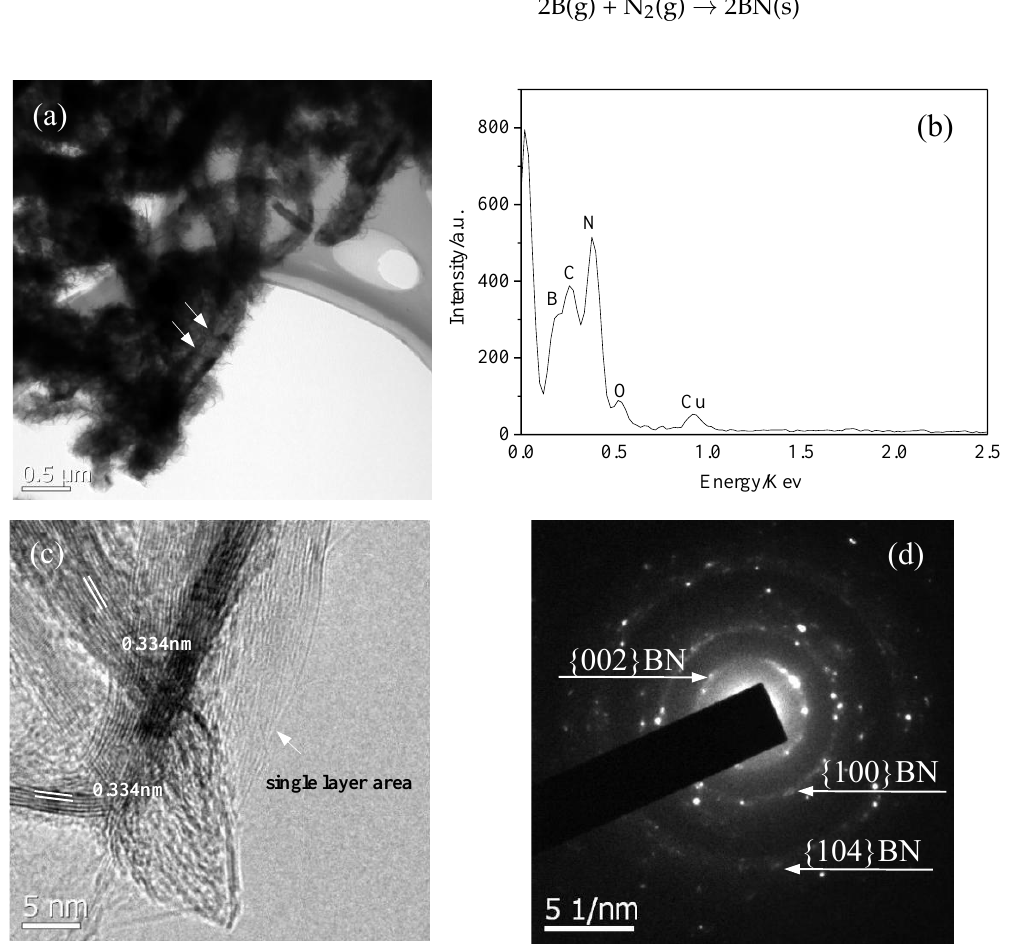
Figure 5. ( a ) TEM image of the product; ( b ) EDS spectrum of the product shown in ( a ); ( c ) HRTEM image of the flakes on the surface of the BN micro-/nanostructure; ( d ) SEAD pattern of the flakes shown in ( c ).